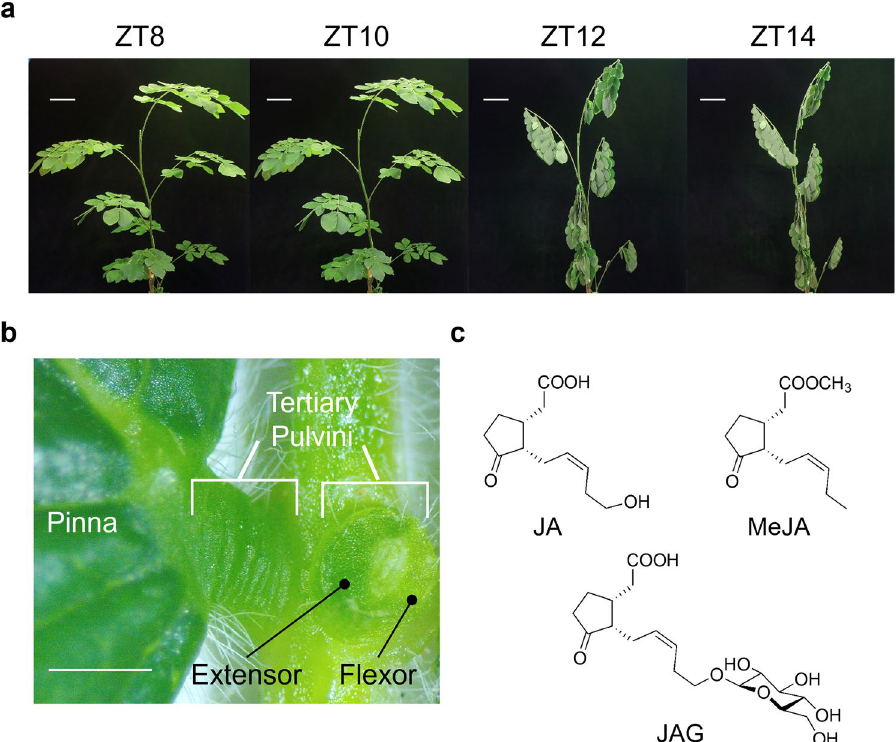
Figure 1. Samanea saman is a standard plant in the study of nyctinasty. ( a ) Images of S. saman during a quarter of circadian rhythm from ZT 8–14 showing leaf-folding movement. Bar = 10 cm. ( b ) Enlarged image of the tertiary pulvini of S. saman . Note that adaxial side is extensor and abaxial side is flexor. Bar = 1 mm. ( c ) Chemical structures of jasmonates: jasmonic acid (JA), methyl jasmonate (MeJA), and 12-hydroxyjasmonic acid glucoside (JAG). Note that JAG is the endogenous chemical factor that induces leaf-folding in S. saman